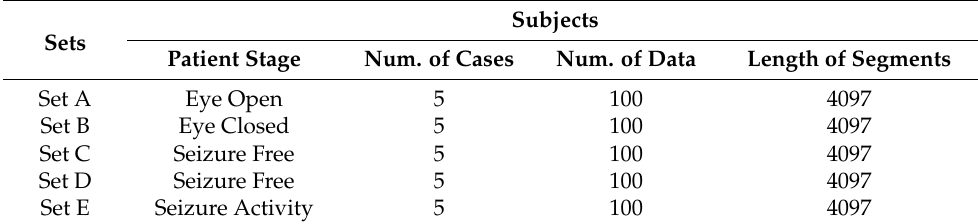
Table 2. Thorough explanation of five subsets of dataset.